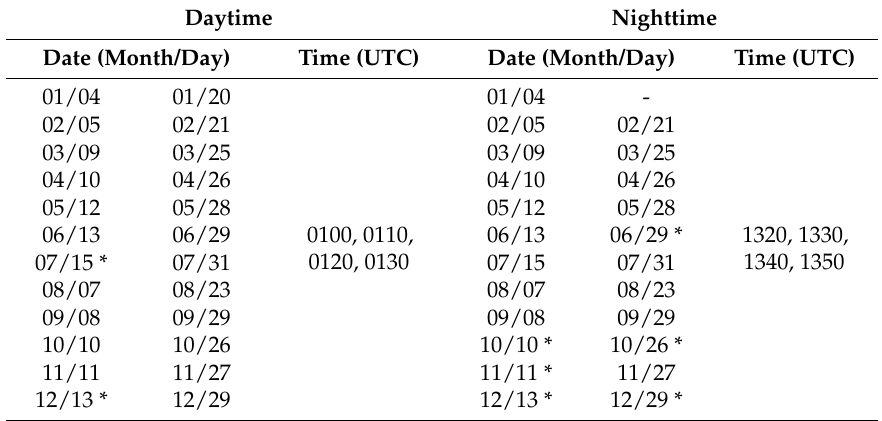
Table 2. Observation time used in the comparative analysis of CERES and